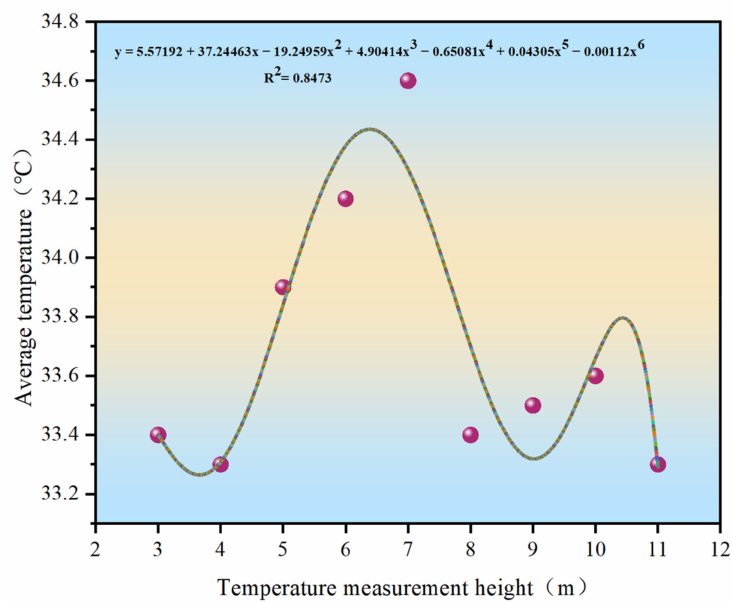
Figure 7. Distribution curve of the average